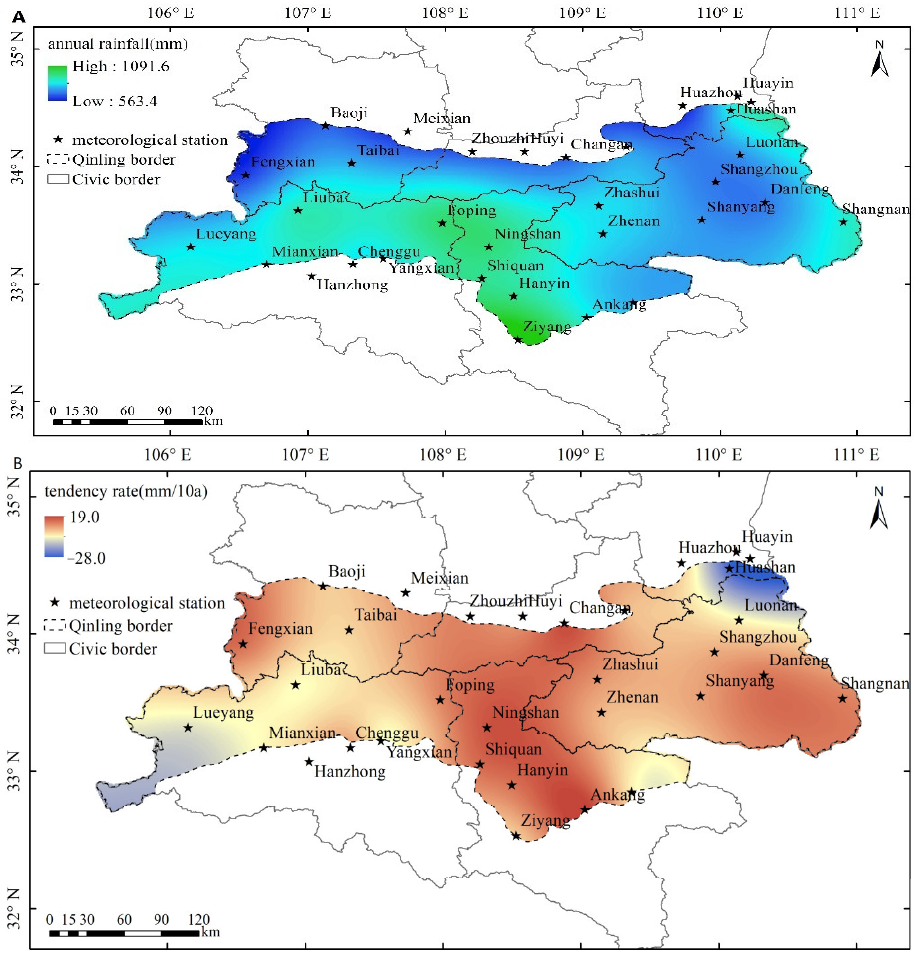
Figure 5. As in Figure 4, but for AMRA ( A ) (unit: mm) and AMRA trends ( B ) (unit: mm/10a). Figure 4. ( A ) The spatial distribution of AMT (unit: ◦ C) in the QMs averaged from 1961 to 2021. ( B ) The spatial distribution of linear variation in AMT trends (unit: ◦ C/10a) in the